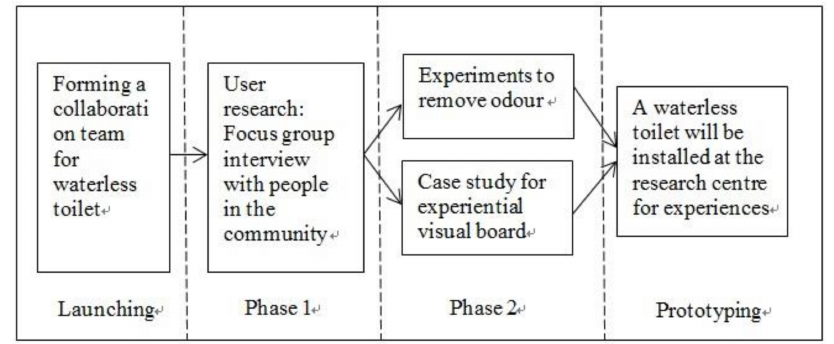
Figure 1. Co-designing a waterless toilet using the fuzzy front end (FFE)